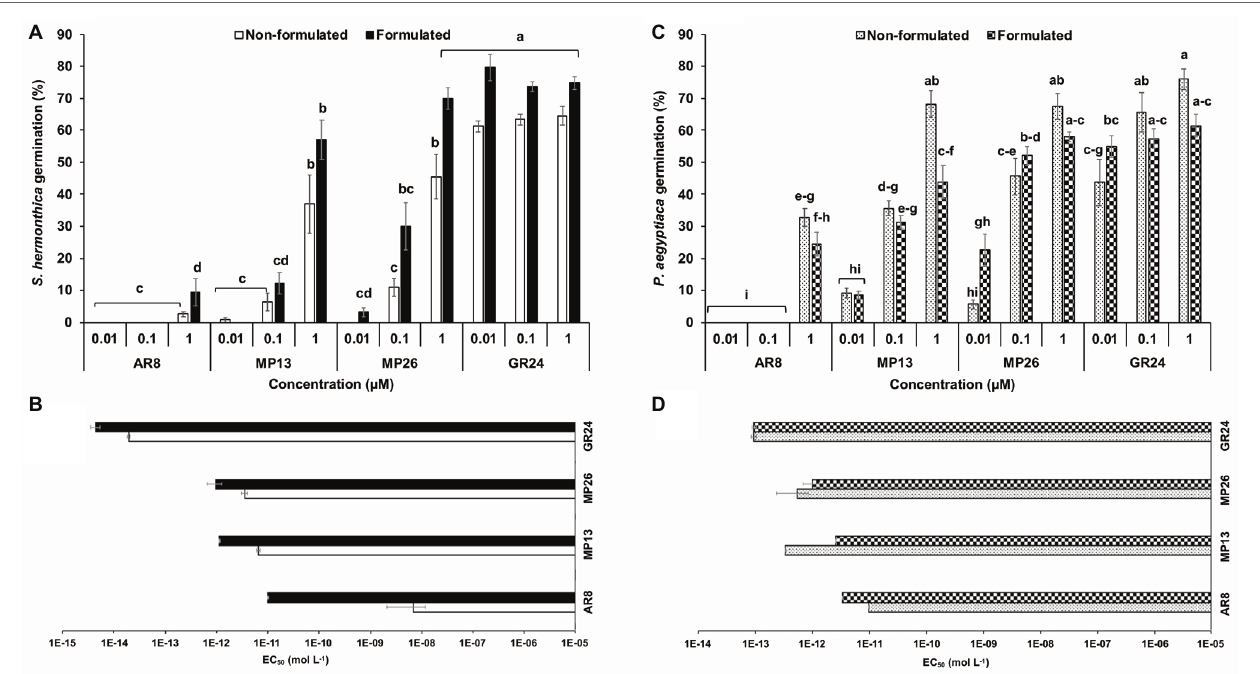
FIGURE 4 | (A,C) Striga hermonthica and Phelipanche aegyptiaca seed germination-inducing activity. (B,D) Half maximal effective concentration (EC 50 ) in response to various doses of formulated and non-formulated AR8, MP13, MP26, and GR24 treatments in petri plates. Preconditioned S. hermonthica and P. aegyptiaca seeds were treated with 50 μ l each of aqueous solutions of AR8, MP13, MP26, and GR24 at 10 −5 –10 −12 M. Bars represent percentage germination ( n = 6), compared by one-way ANOVA and LSD 0.05 . Means not sharing a letter in common differ significantly at p 0.05